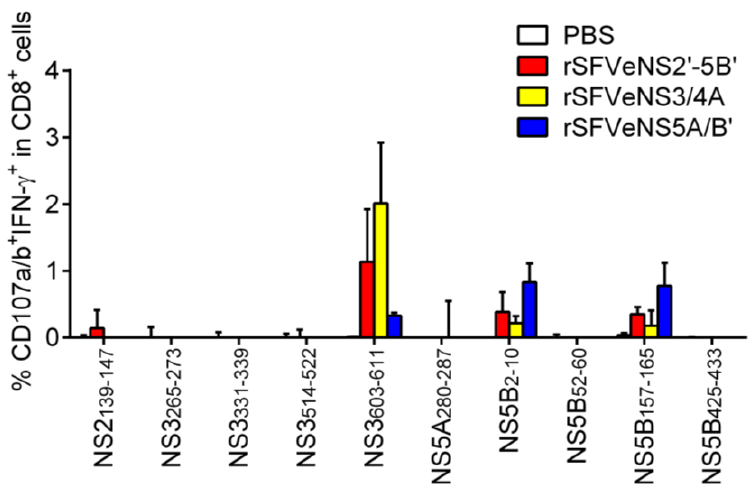
Figure 3. Induction of peptide-specific effector CD8 + T cells in vivo . Mice were intramuscularly immunized thrice with rSFV expressing HCV nsPs (rSFVeNS2'-5B', rSFVeNS3/4A or rSFVeNS5A/B') or PBS control with a one-week interval. Mice were sacrificed 1 to 3 weeks after the boost immunization. Splenocytes were isolated and cultured with 10 μg/mL of peptides for 5 h before surface and intracellular staining. Background (splenocytes incubated with an equivalent concentration of DMSO) subtraction was applied and values above background are shown. Data represent combined results from three independent experiments, showing the mean +SEM (3–5 mice per